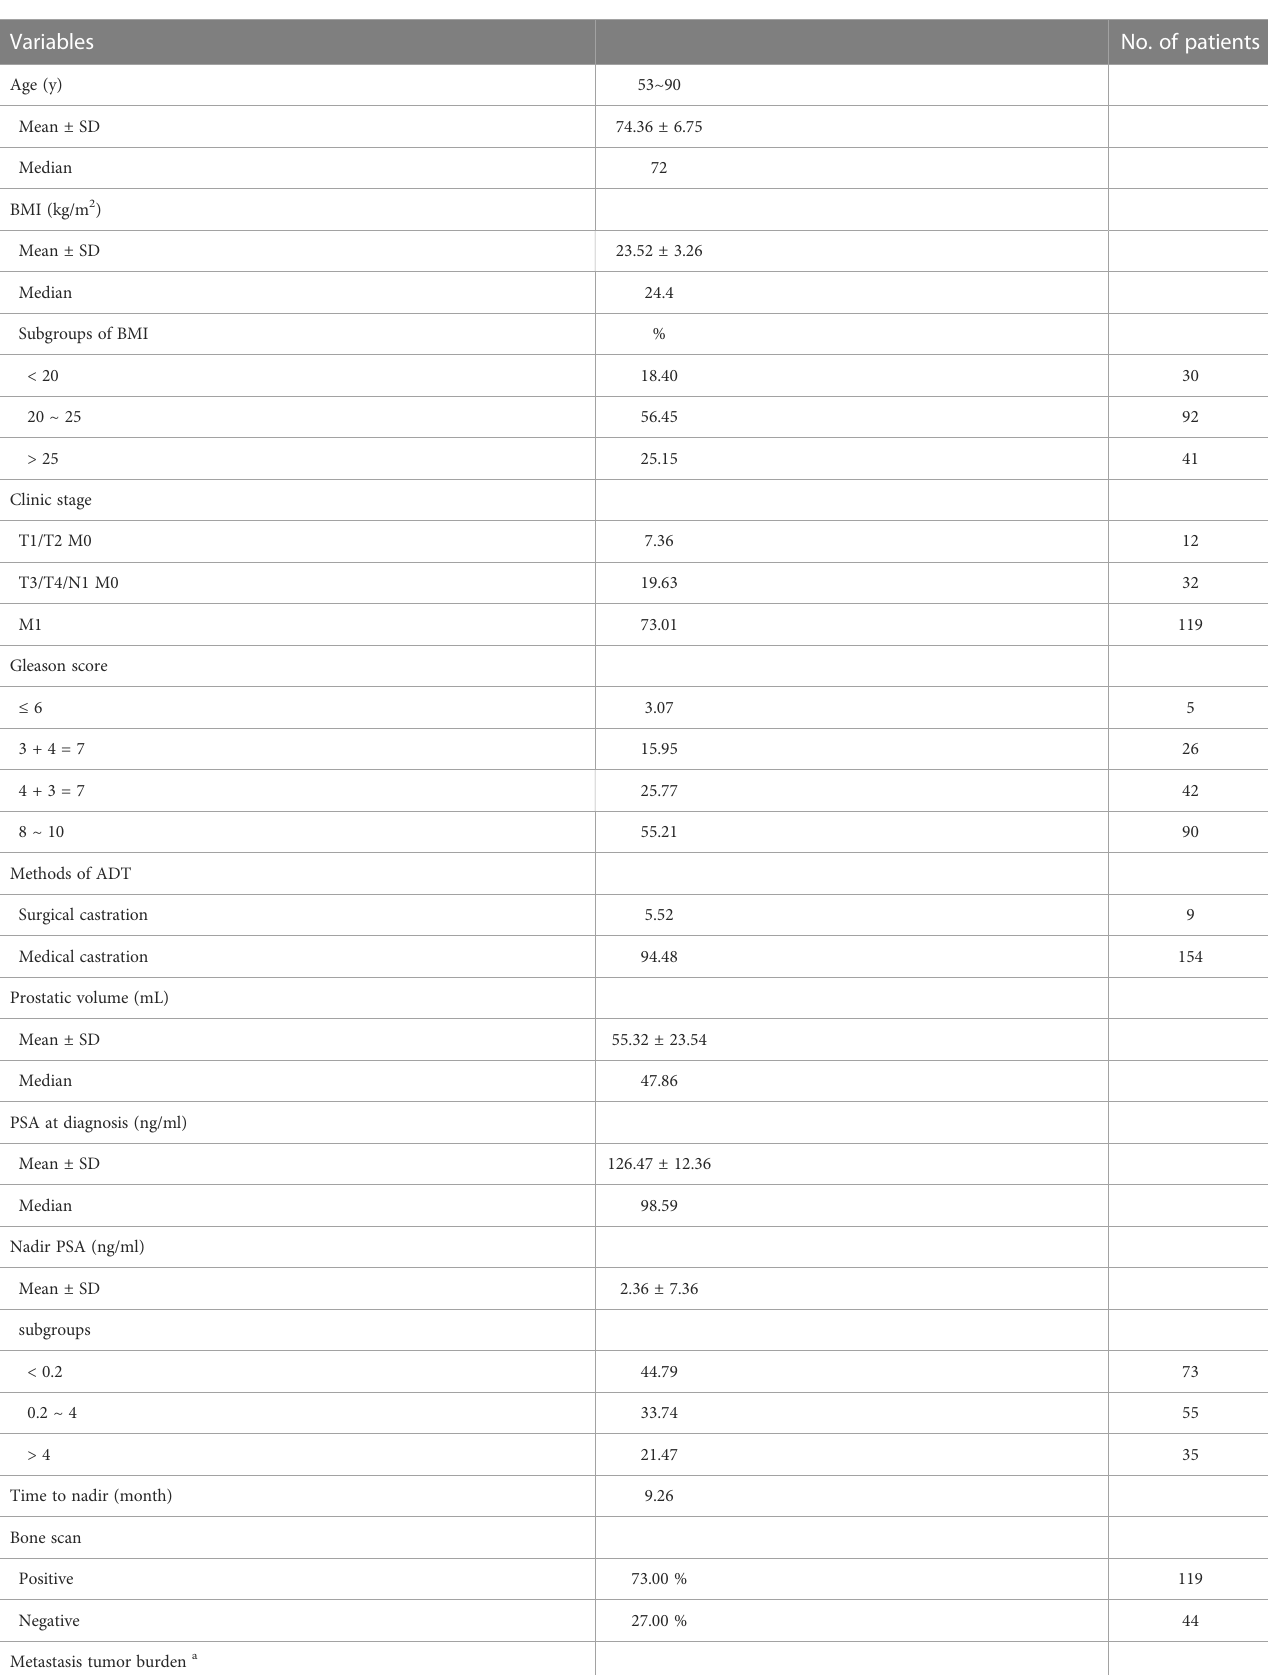
TABLE 1 Baseline characteristics of patients with prostatic cancer.